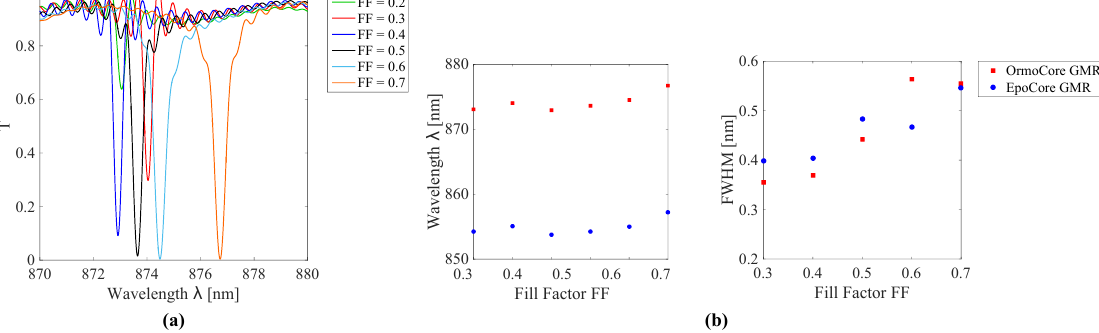
Figure 6. ( a ) Simulated transmission spectra for GMR gratings in EpoCore with varying fill factor FF . ( b ) The simulated resonant wavelength and FWHM as a function of the FF for the GMR grating in OrmoCore and EpoCore. The used grating parameters are listed in Table